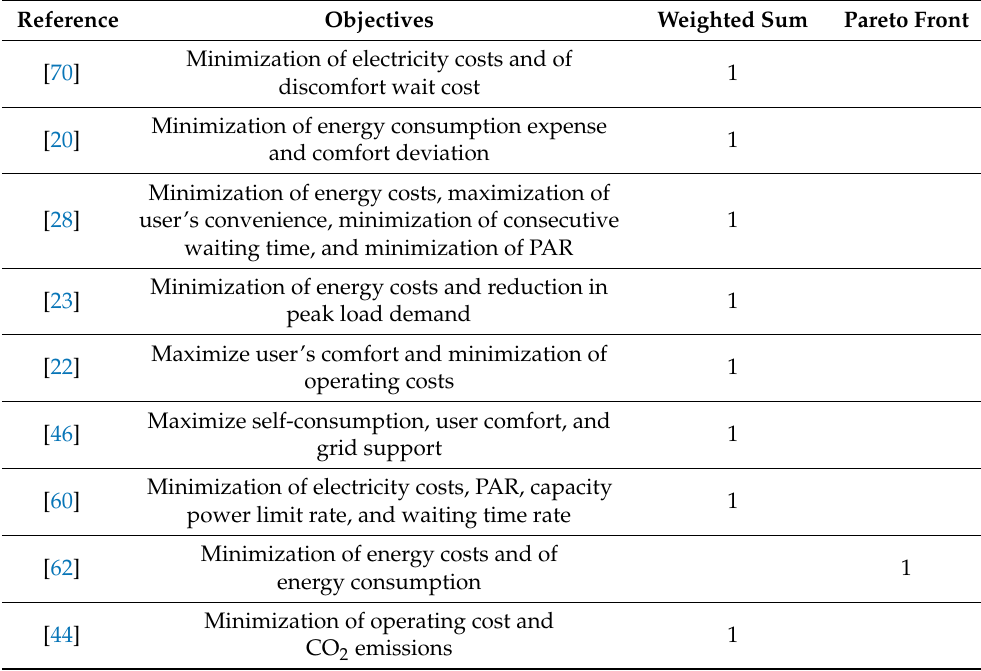
Table 18. Objectives associated with multi-objective problems from the list of the selected papers. Reference Objectives Weighted